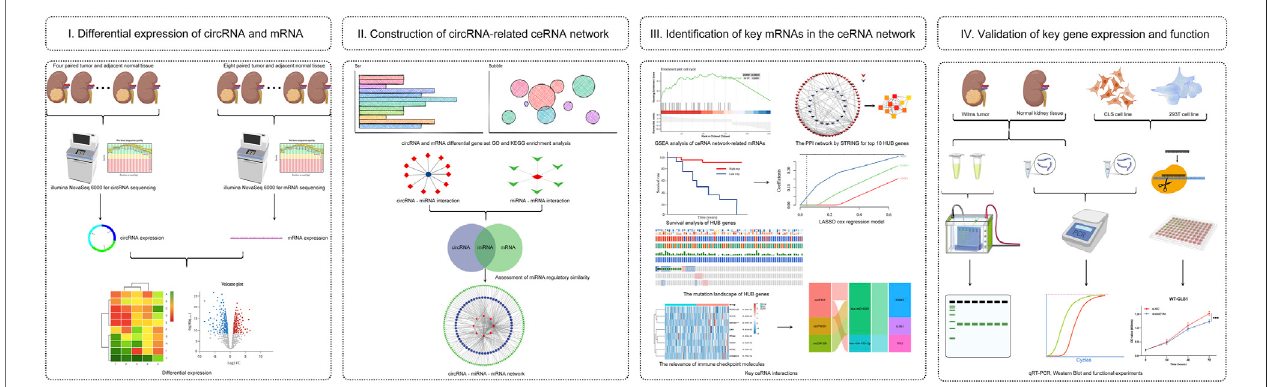
FIGURE 1 | Analysis fl owchart. (I) Identi fi cation of differentially expressed circRNA (DE-circR) and mRNA (DE-mR) by tumor tissue sequencing in Wilms tumor. (II) GO and KEGG pathway enrichment analyses of DE-circRs ’ parental genes and DE-mRs; Construction of circRNA-miRNA-mRNA regulatory network based on same miRNA binding sites. (III) Identi fi cation of key mRNAs in the circRNA-related network, including GSEA, PPI network analysis, survival analysis, mutation analysis, and immune response analysis. (IV) Validation for key circRNAs and mRNAs in clinical samples and cell lines by qRT-PCR and western blot analysis, and functional validation of candidate